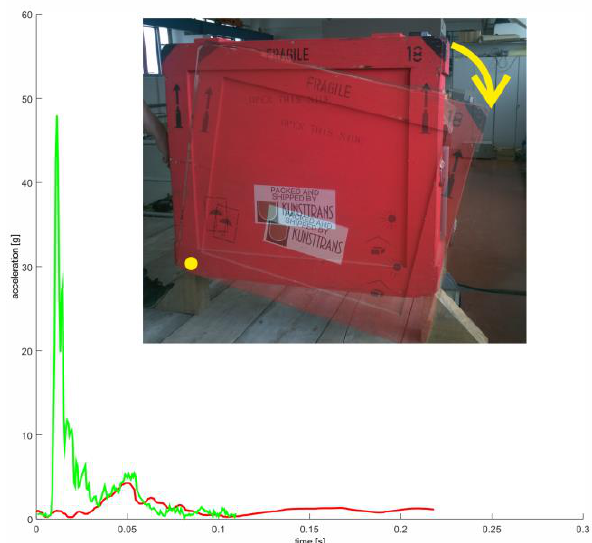
Figure 5. Example of dual acceleration measuring sensor enabling optimization of transport box design in order to maximize attenuation capabilities and thus object’s protection. Example of drop test acceleration measurement: green line – accelerations on transport box, red line – acceleration on object (painting) inside. Painting faced about ten time lower accelerations then the box.